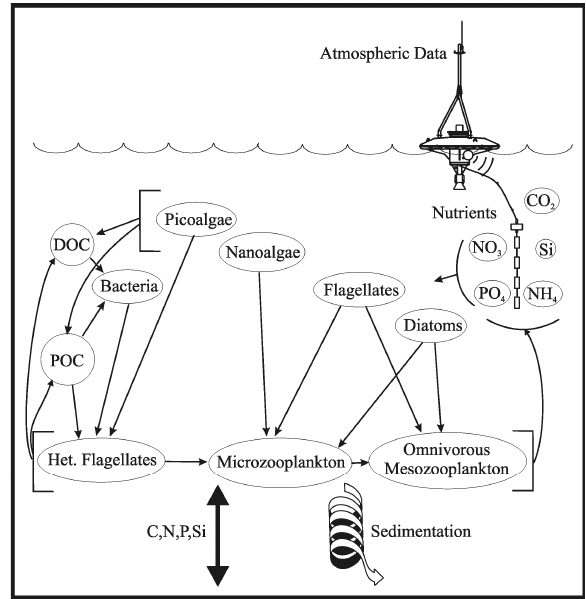
Fig. 2. Ecosystem model food